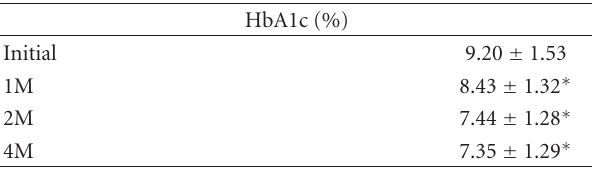
Figure 1: Schematic image of OCT scanning for retinal nerve fiber layer (RNFL) thickness measurements. The circle shows a 360 ◦ circular scan with 3.4mm diameter. Two lines divide the circle into 4 quadrants (temporal, superior, nasal, inferior). Table 1: Change in HbA1c during glycemic